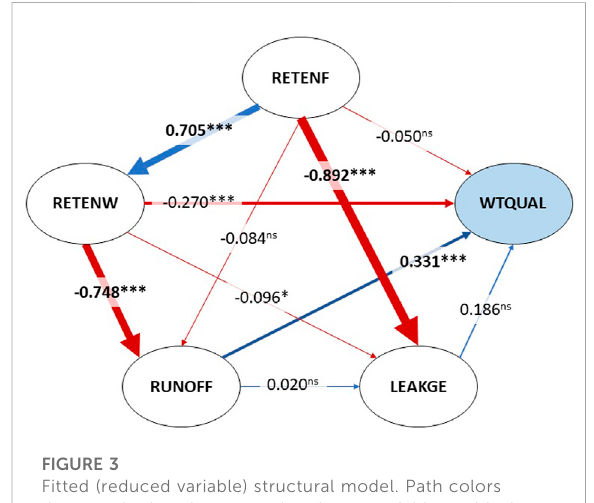
FIGURE 3 Fitted (reduced variable) structural model. Path colors denote whether the antecedent latent variable positively (blue) or negatively (red) effects the descendent latent variable. For example, RETENF increases RETENW, but decreases LEAKGE. Numbers adjacent to links denote standardized coef fi cient sizes. See Table 6 for signi fi cance levels.